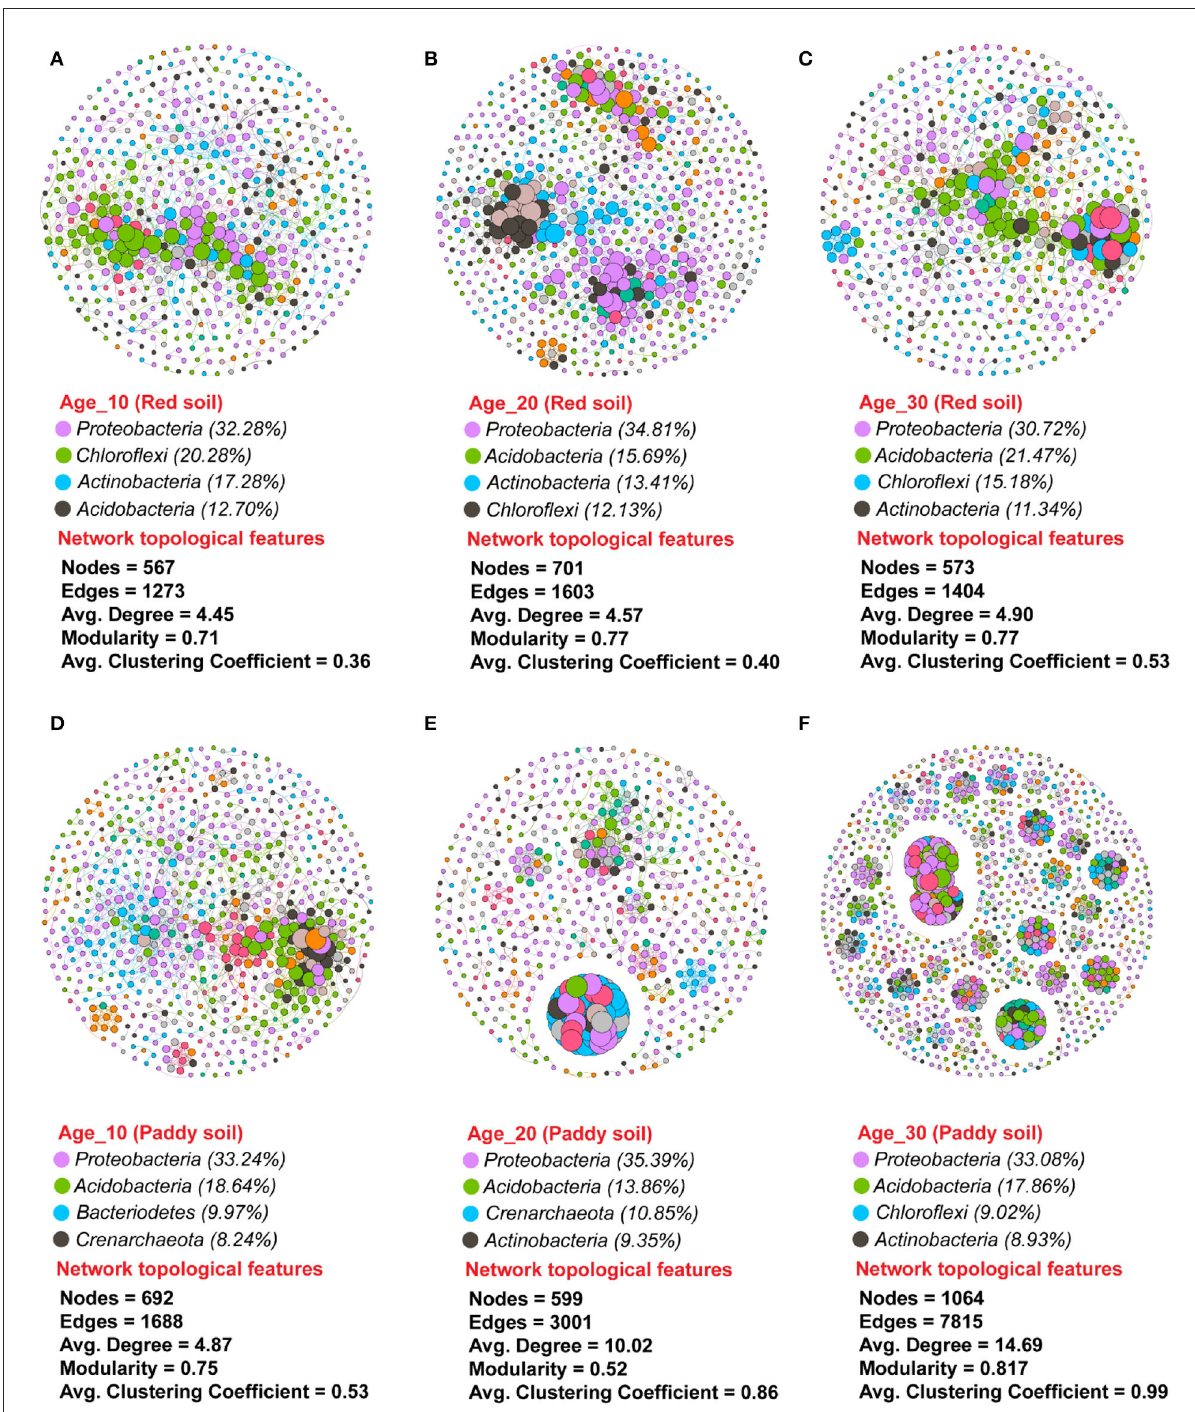
FIGURE8 Dynamic changes in bacterial co-occurrence networks under different groups of tree ages. Co-occurrence network was investigated for (A–C) red soil and (D–F) paddy soil. Each node in the network has a different color based on its phylum. The size of each node indicates the taxa’s relative abundance. The connections are significant ( P ≤ 0.05) and strongly correlated (Spearman’s ρ ≥ 0.6). Here, Age_10, Age_20, and Age_30 denote the different pomelo tree ages of 10, 20, and 30 years,